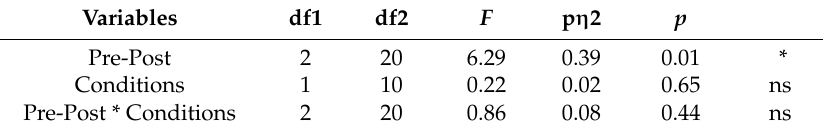
Table 5. The result of ANOVA of heart rate of the trauma group.